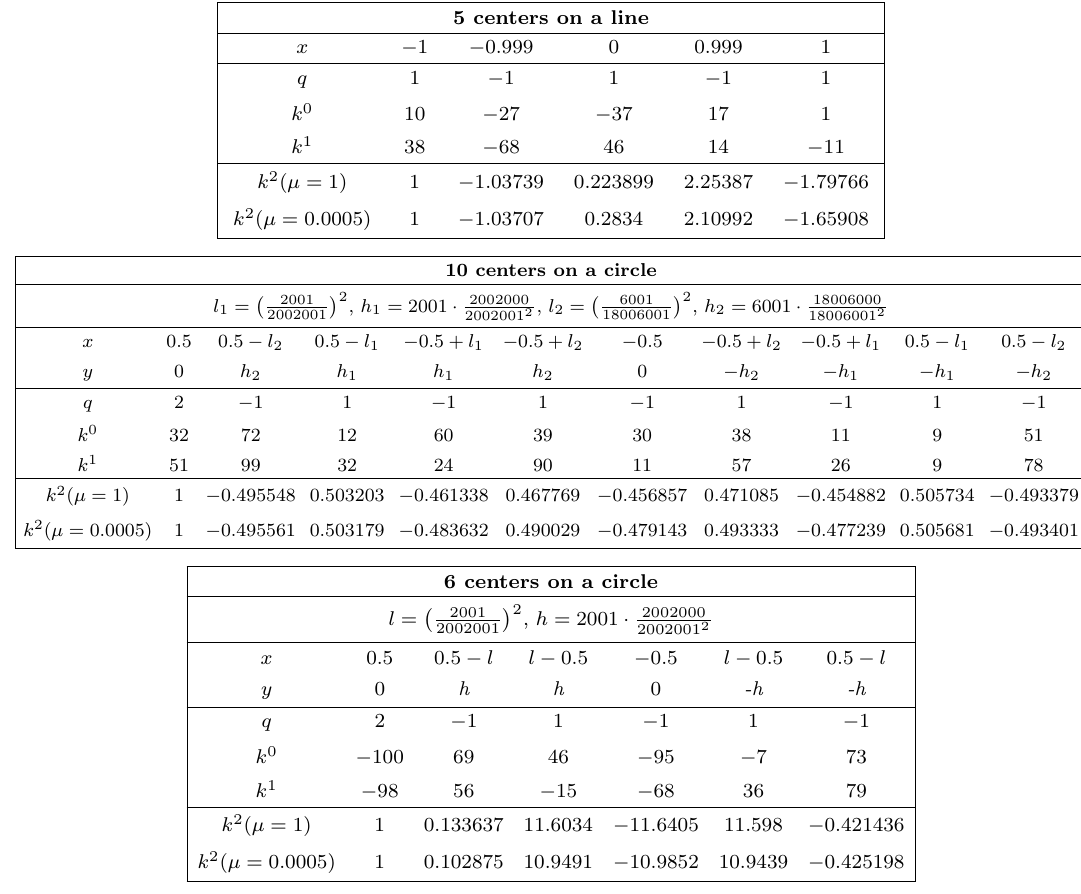
p p = 2, l 2 = 1 = 2 and g = 1 for all the 0 0